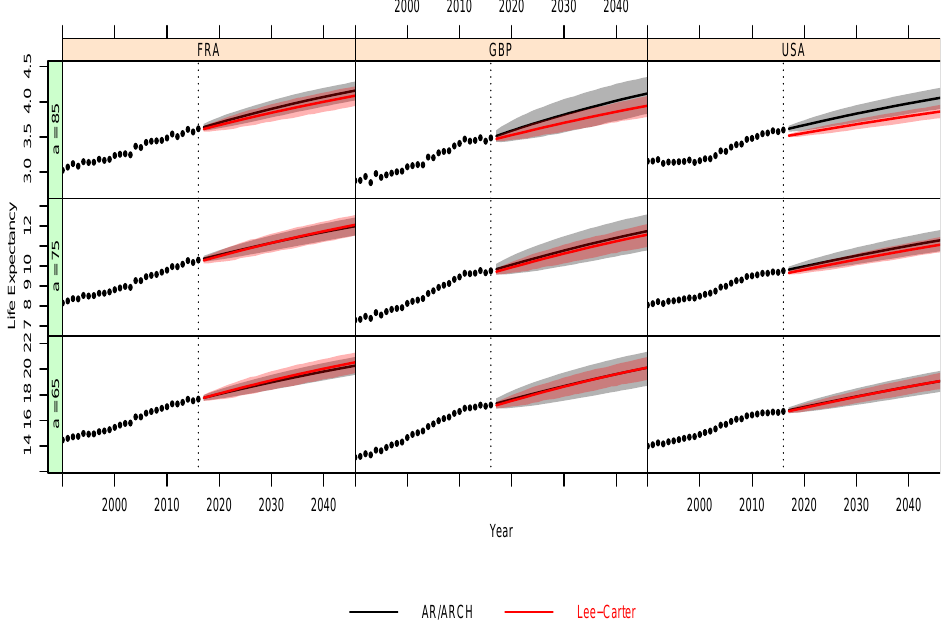
Figure 7. Life expectancy: Forecast life expectancy at age 65, 75, and 85 for the France, England and Wales, and US populations produced by both the selected AR-ARCH (black) model and Lee–Carter (red) model. The 95% prediction intervals are also